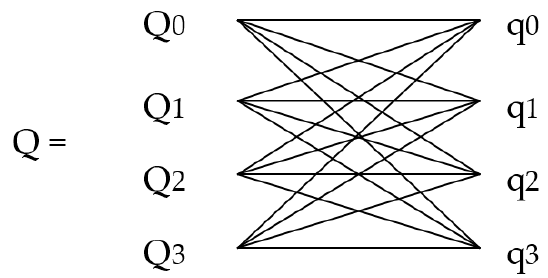
Figure 4. The constraint layer transforms the outputs of the four neurons {Q 0 , Q 1 , Q 2 , Q 3 } into quaternion unitized vectors.